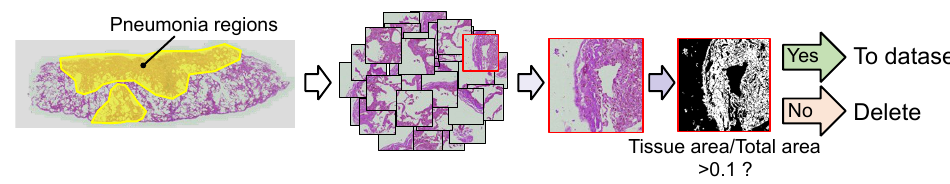
Figure 2. Preparation of patch images.